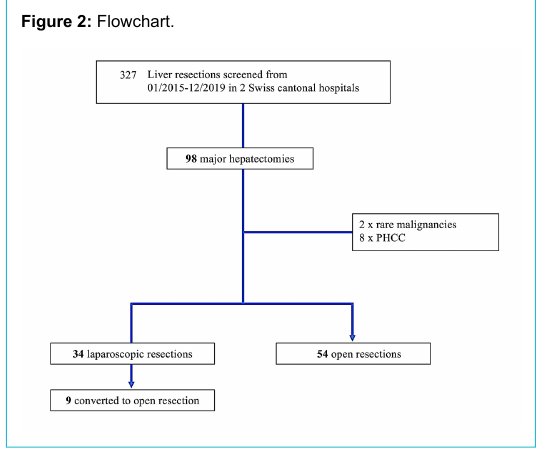
Table 2: Surgical outcome of patients with major hepatectomy in cantonal hospitals Winterthur and Lugano 2015–2019.